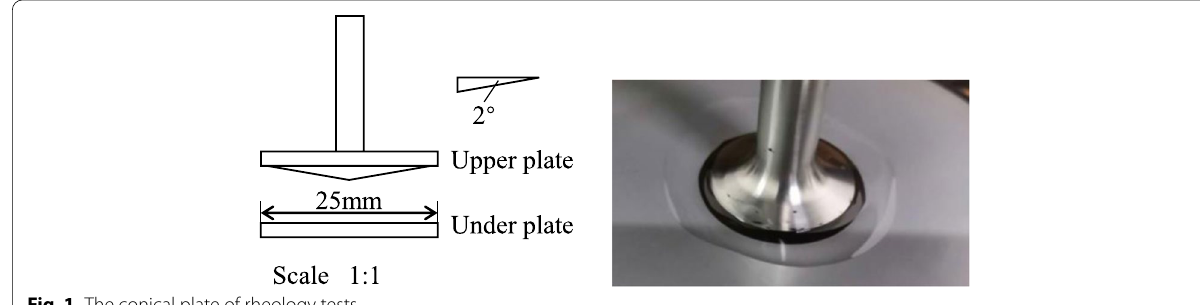
Fig. 1 The conical plate of rheology tests